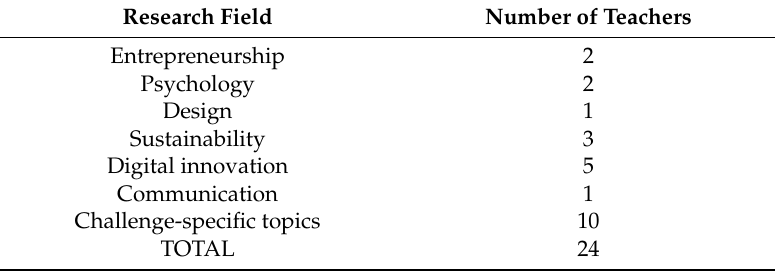
Table 4. Number of professors divided according to their research